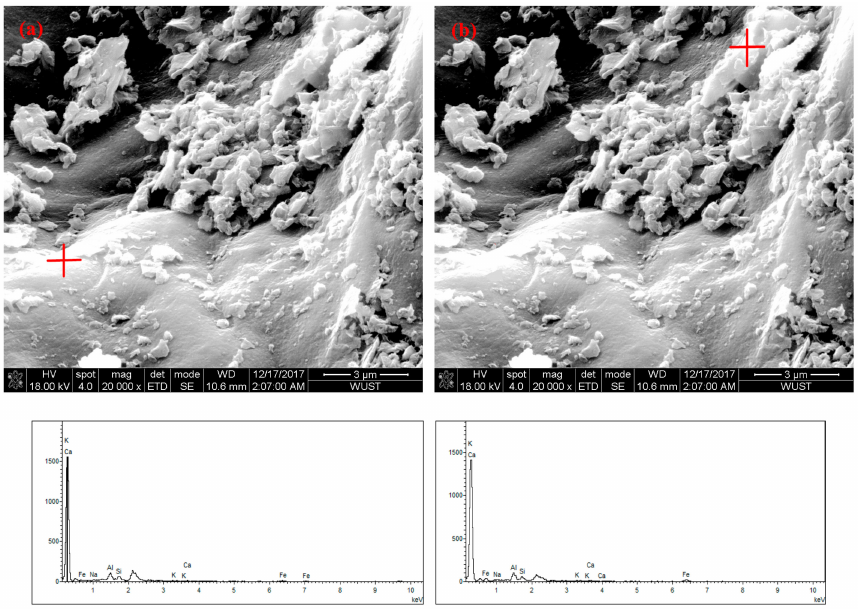
Figure 5. SEM images ( a , b ) and EDS analyses of the reacted coke. Table 6. Chemical composition of slag-like found on partially dissolved coke samples.